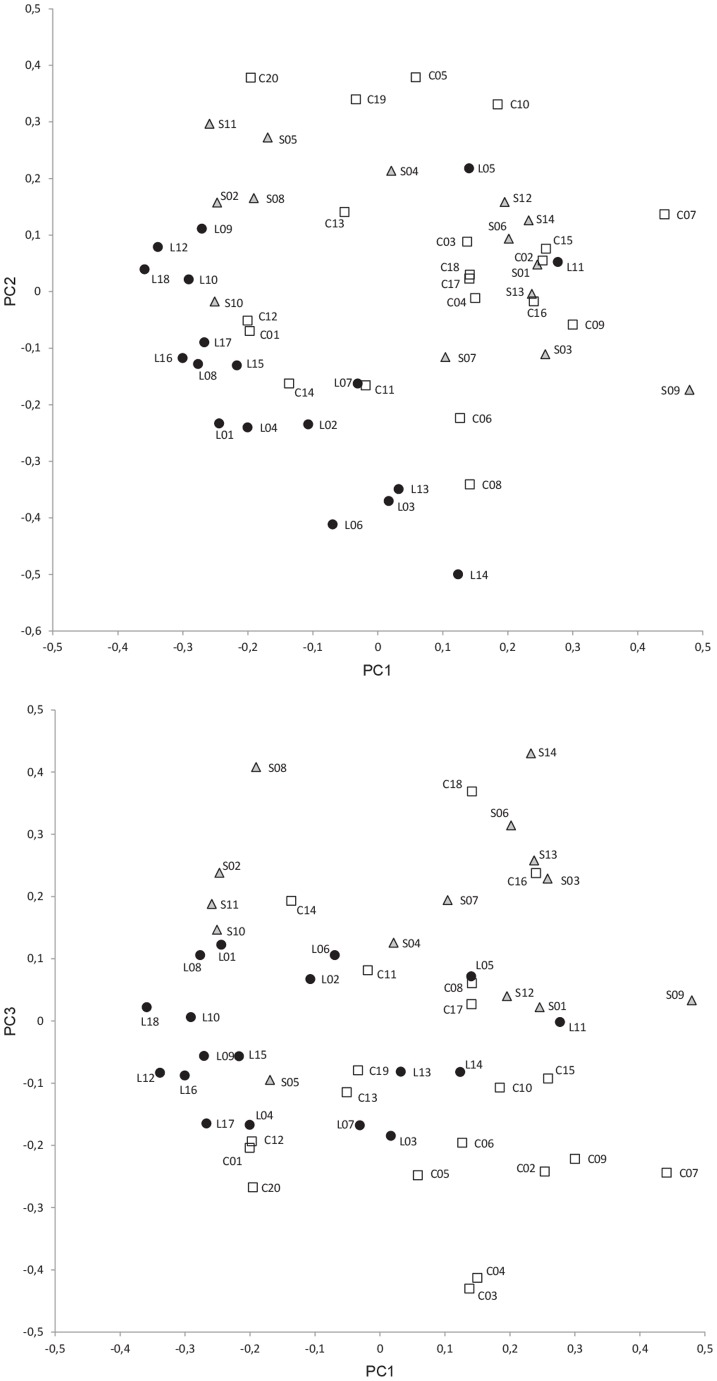
PCA SSR-based relationships between accessions.A total of 52 S. melongena accessions from China (white squares), Spain (grey triangles), and Sri Lanka (black circles) (see Table 1) were evaluated using 12 polymorphic SSRs (see text and Tables 3 and 5) and were represented on the three first components (PC1, PC2 and PC3) of the principal components analysis (22.0%, 19.1%, and 17.9% of the total variation explained by the first, second, and third principal components, respectively). Scatterplots show the projections of the accessions on the first and second principal components (above) and on the first and third principal components (below).